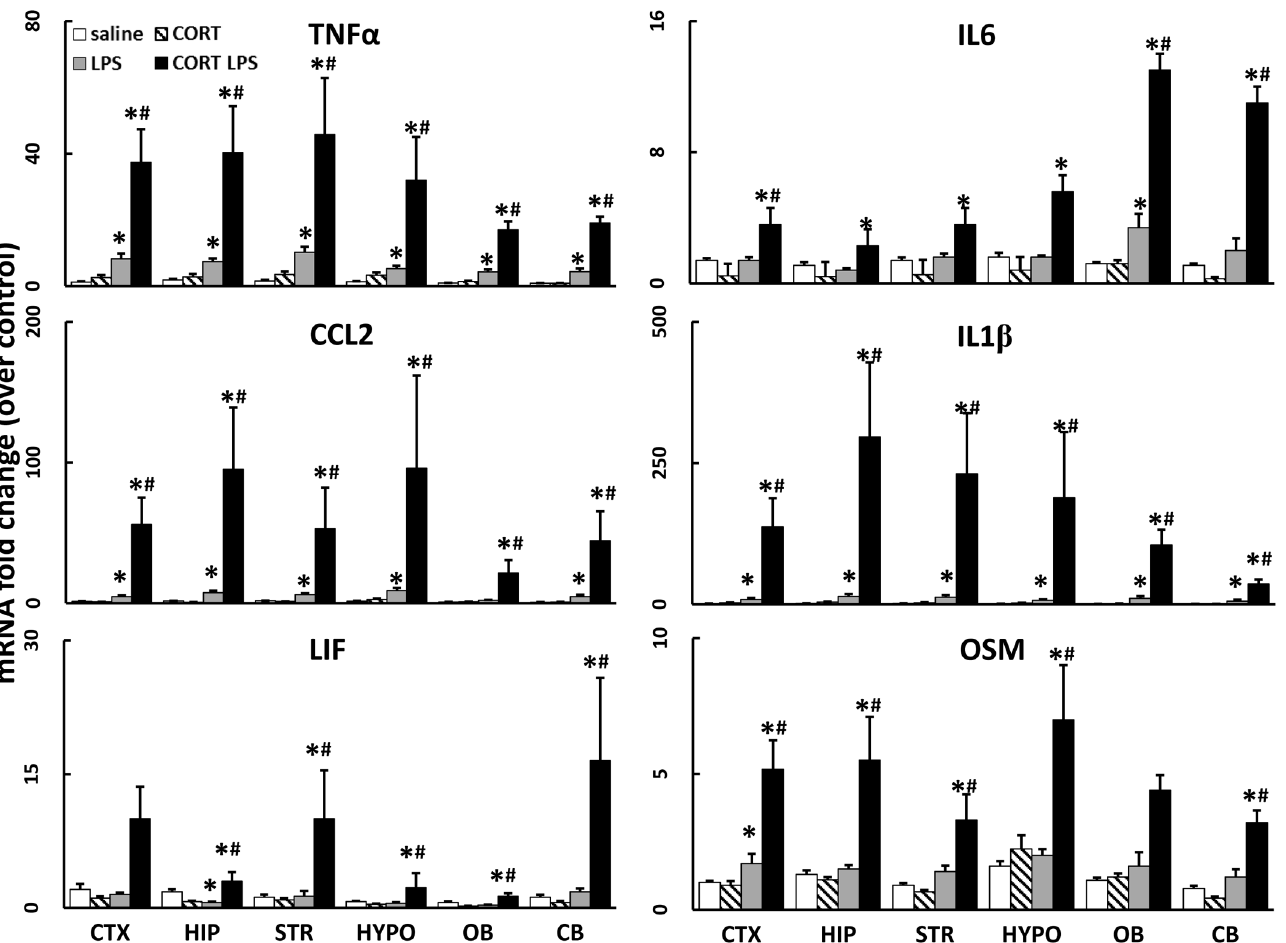
Fig 2. Chronic CORT exacerbates LPS-induced neuroinflammation brain wide. The effects of chronic CORT pretreatment (200 mg/L 0.6% EtOH in drinking water for one week) on LPS (2 mg/kg, s.c.)-induced TNF α , IL-6, CCL2, IL-1 β , LIF, and OSM mRNA levels were measured in samples prepared from cortex (CTX), hippocampus (HIP), striatum (STR), hypothalamus (HYPO), olfactory bulb (OB), and cerebellum (CB) 6 hours after LPS exposure. Data represents mean ± SEM (n = 5 mice/group). Statistical significance of at least p < 0.05 is denoted by (cid:3) as compared to control, # as compared to LPS alone.